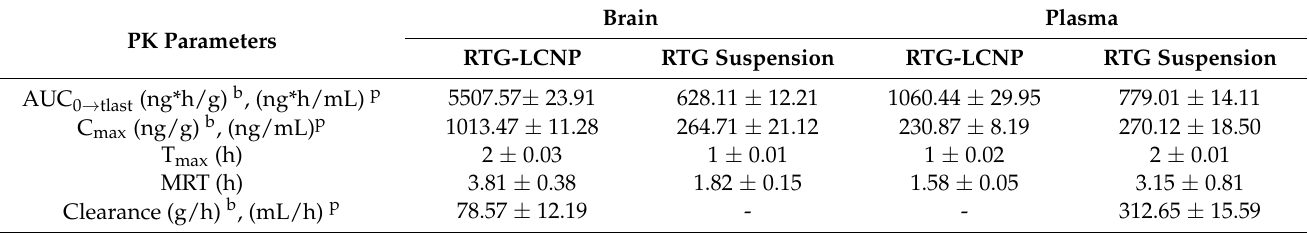
Figure 7. Mucociliary transport time of aqueous RTG suspension and RTG-LCNP (LCNP 15). Stu- dent ’s independent t-test with one- tail was applied. ‘****’ shows p -value <0.05. dent’s independent t -test with one-tail was applied. ‘****’ shows p -value <0.05. Table 6. Plasma and brain PK parameters for RTG-LCNP (LCNP 15) and RTG suspension after i.n.